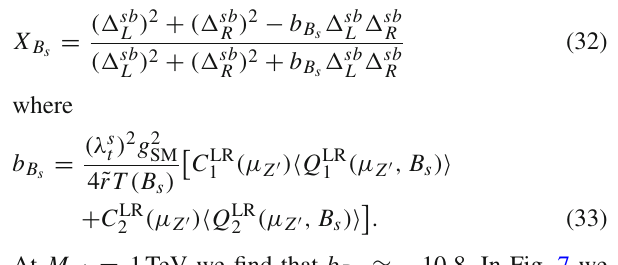
Table 5 Predictions for R the parameter space for M Z (cid:3) = 1TeV allowed by both (cid:5) M B